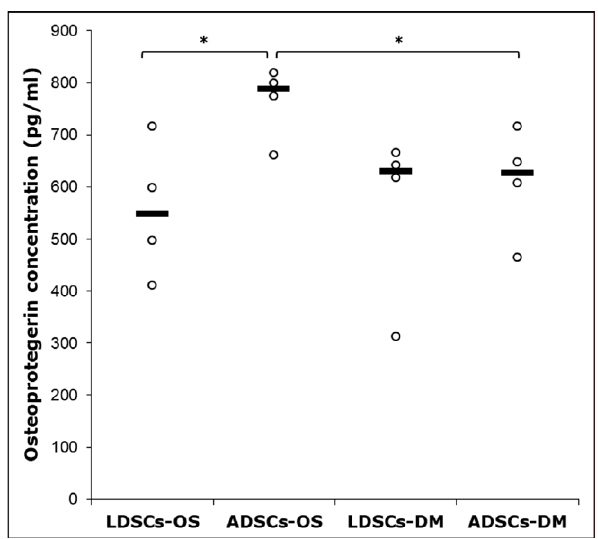
Figure 11. Osteoprotegerin concentration in cell culture supernatant of LDSCs and ADSCs, measured by ELISA at day 16 of osteogenic differentiation; scatterplots with median; n = 4 for all groups; (*) p < 0.05. Cells 2018 , 7 , x FOR PEER REVIEW